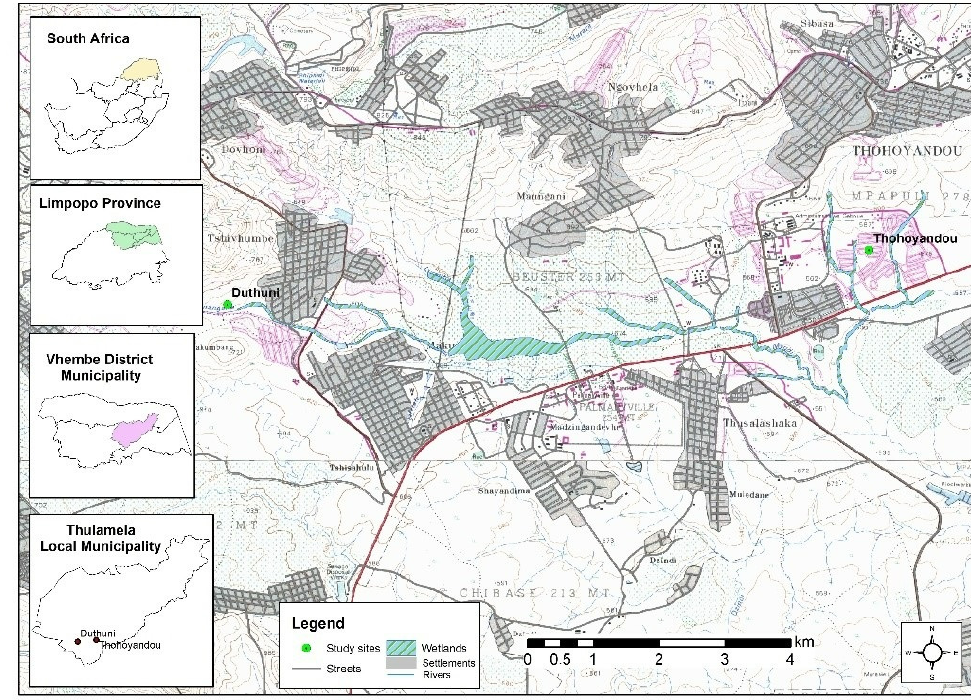
Figure 2. Location of the wetlands in urban vs. rural areas of Thohoyandou in the Vhembe district, Limpopo